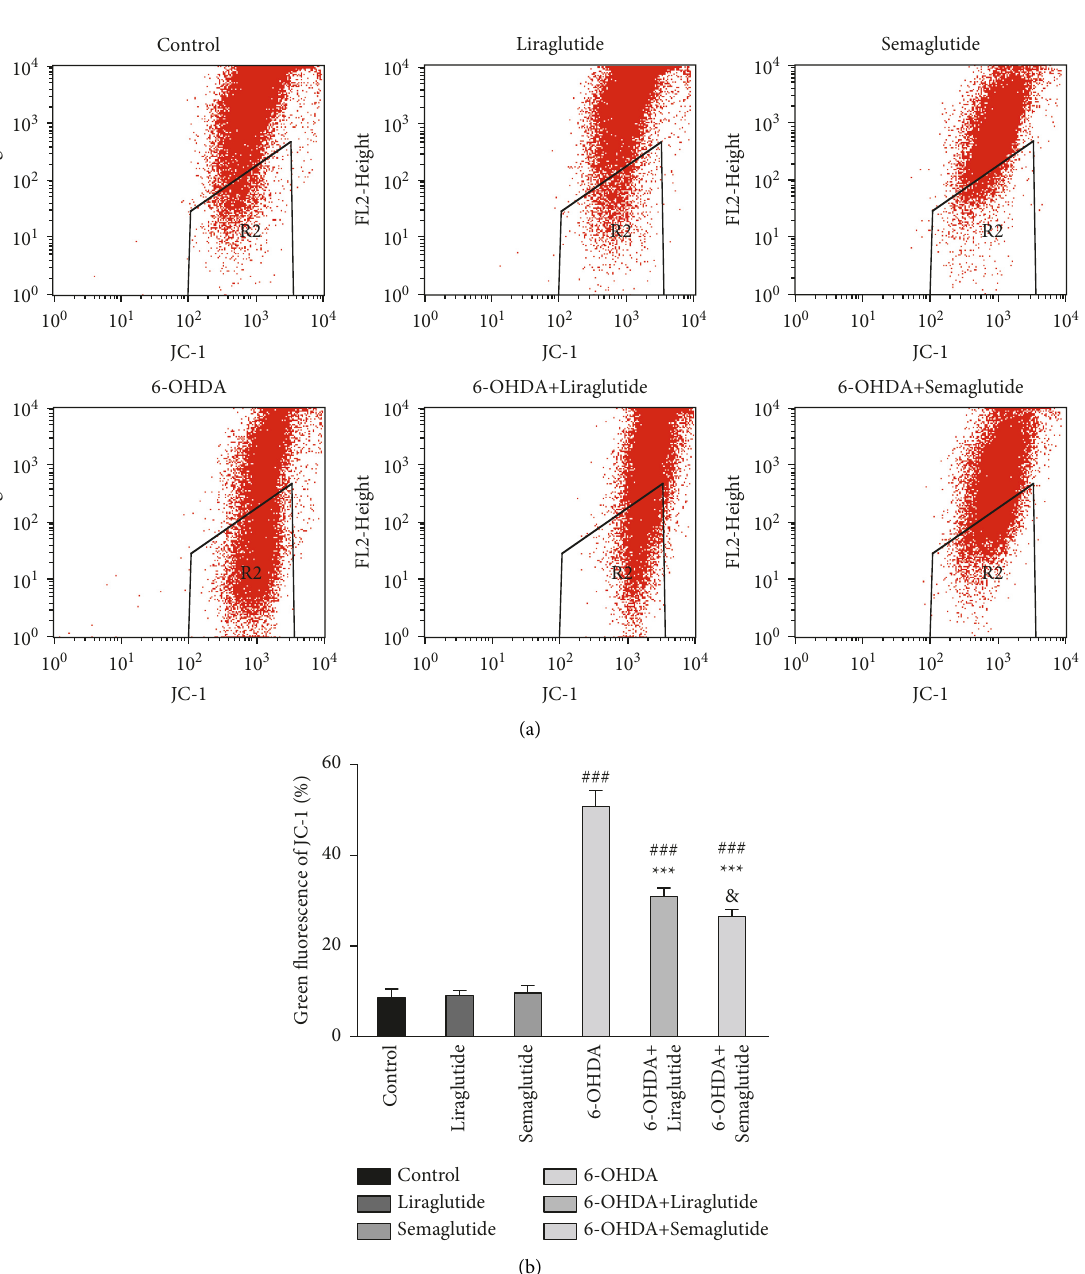
m ). (b) The green fluorescence of JC-1 was upregulated in the 6- 0 . 05 vs. 6-OHDA +liraglutide group). All data were expressed as ΔΨ <